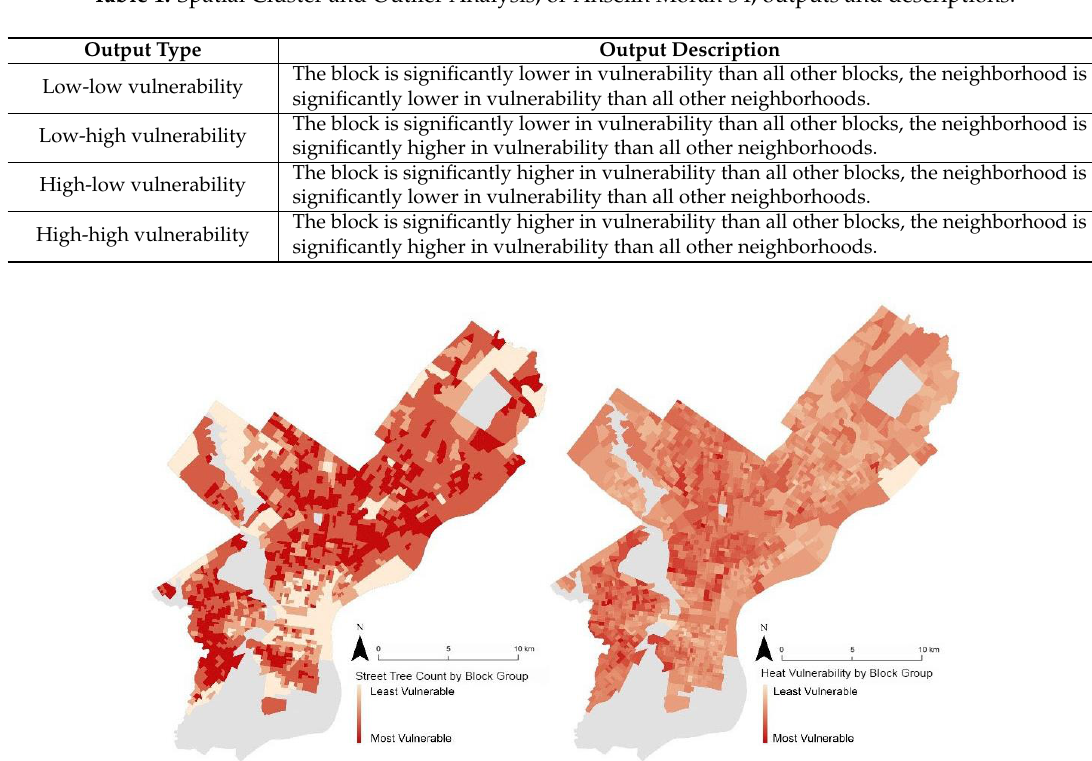
Figure 2. Vulnerability by block group for street trees ( left ) and heat ( right ). Vulnerability scales from 1 to 25 with lightest colors representing least vulnerable and darkest colors representing most vulnerable as compared to other block groups in the study area. Note: the light gray area represents areas of no data.